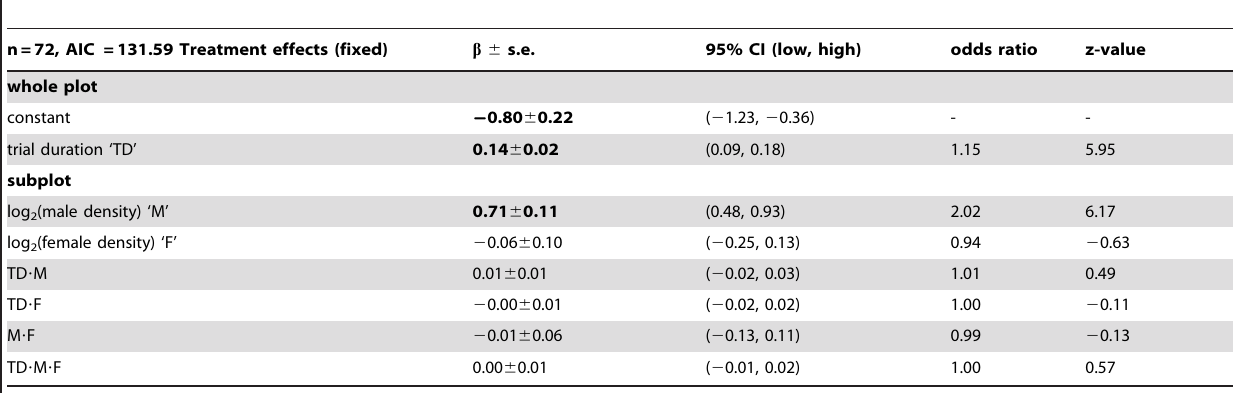
Table 1. Results of the (logistic) regression model of the ln-transformed odds of fertilization for female Leptinotarsa decemlineata (Colorado potato beetles) { .